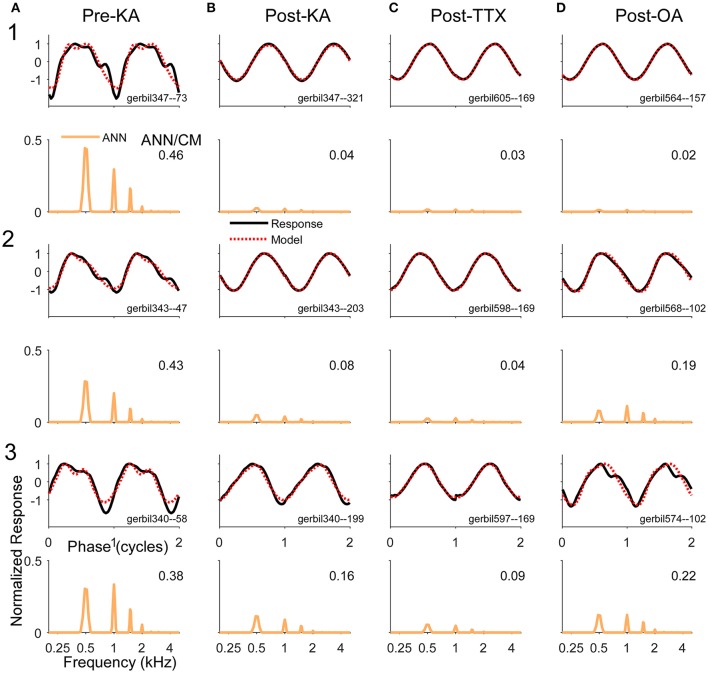
Examples of waveforms and frequency spectra of ECochG signals in response to 500 Hz tone burst at 50 dB SPL (A). Three examples (1–3) recorded prior to KA. The waveforms shown strong distortions and in the ECochG and model waveforms (top panels) and the ANN has multiple harmonics in its spectra (bottom panels). Both sets of data were normalized by the maximum response. The numbers in the spectra represent the ANN/CM ratio. The CM is not shown. (B–D) Three examples each (1–3) recorded after KA, TTX, and OA, respectively. The waveforms show less distortion and smaller ANN/CM ratios, although the ANN is not completely removed in most cases. The cases (1–3) are in order of least to most remaining ANN for that drug. The Pre-Drug condition for TTX and OA are not shown, but were similar to that for Pre-KA.